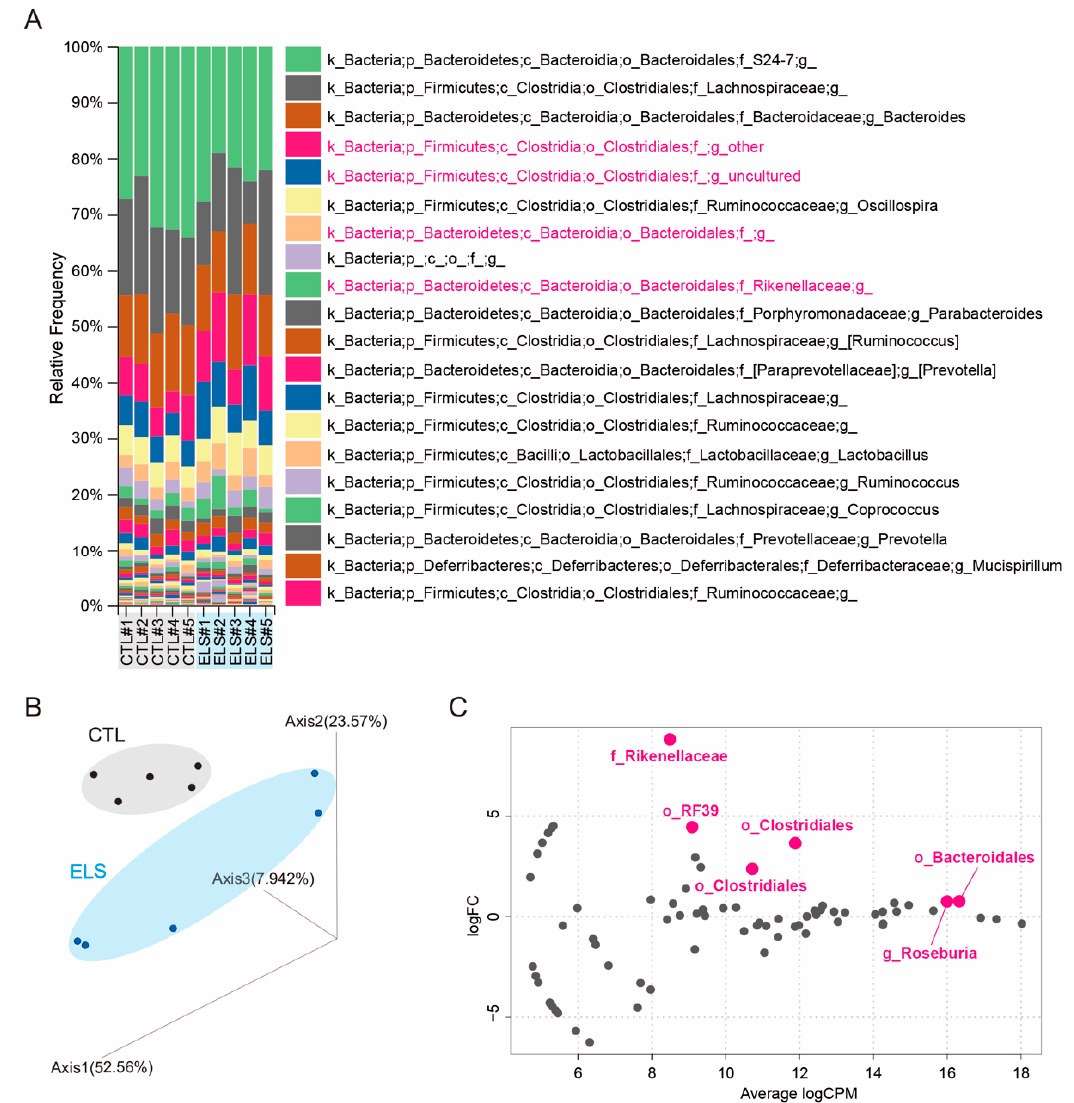
Figure 1. Early life stress-influenced gut microbiota alterations in mice. ( A ) The top 20 relative abundant taxa were shown at the genus level. ( B ) Principal coordinates analysis (PCoA) on the OTU level. ( C ) MA plot showing significant difference in the gut microbiota in early life stressed (ELS) mice. The significantly altered gut bacteria are shown in magenta. CTL, control mice; ELS, early life stressed mice, n = 5/condition.